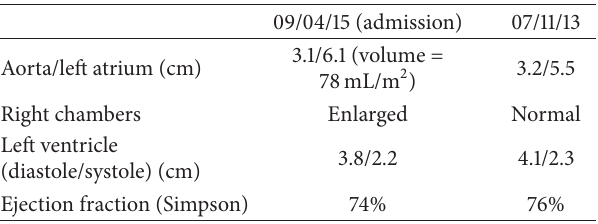
Figure 1: Increased cardiac area, middle arch rectification, left atrial increase, bilateral hilar lymphadenopathy, and calcified and Kerley B lines. Table 1: Transthoracic